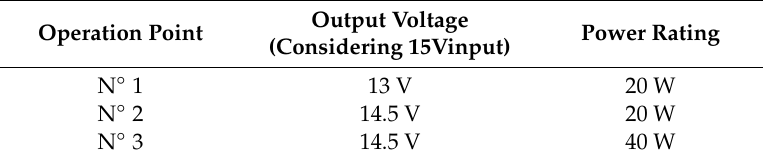
Table 3. Description of the three operating points used to characterize each single